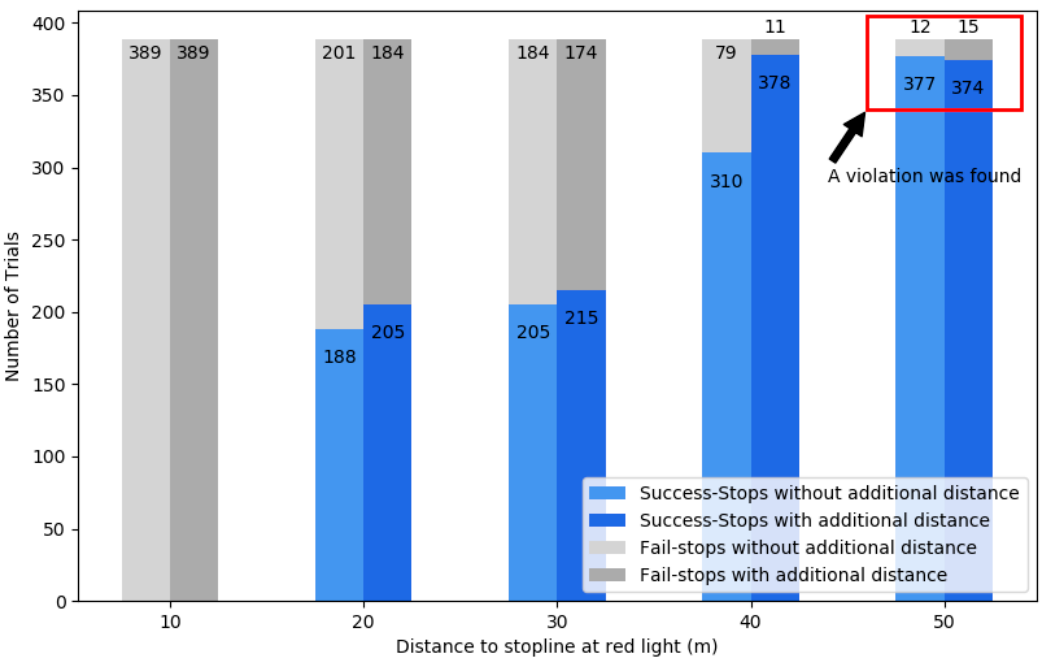
Figure 14. Stop behind the stop line in the red light test.